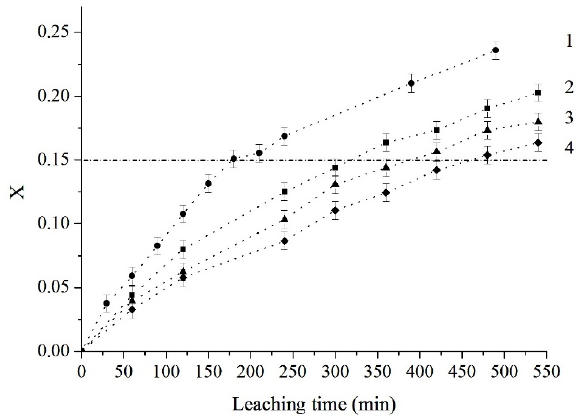
Figure 4. Dependence of the titanium leaching degree on the time of the ground altered ilmenite processing at a temperature of 100 °C and acid concentrations: 85 wt% (1), 80 wt% (2), 60 wt% (3), and 50 wt% (4). The dashed line shows the degree of conversion at which the reaction mixture solidifies.